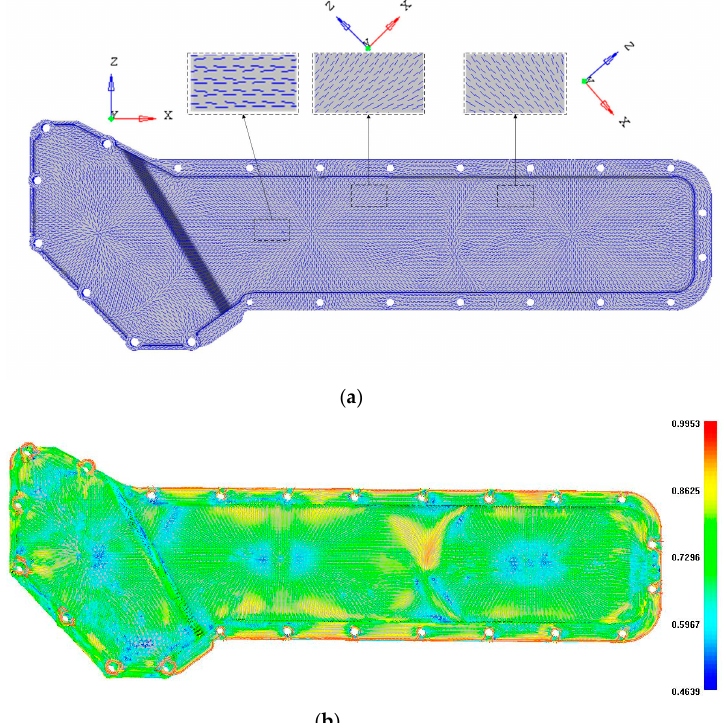
Figure 9. The fiber orientation of the plastic oil cooler cover, ( a ) the fiber orientation and ( b ) the corresponding 2nd order fiber orientation tensor (a11).